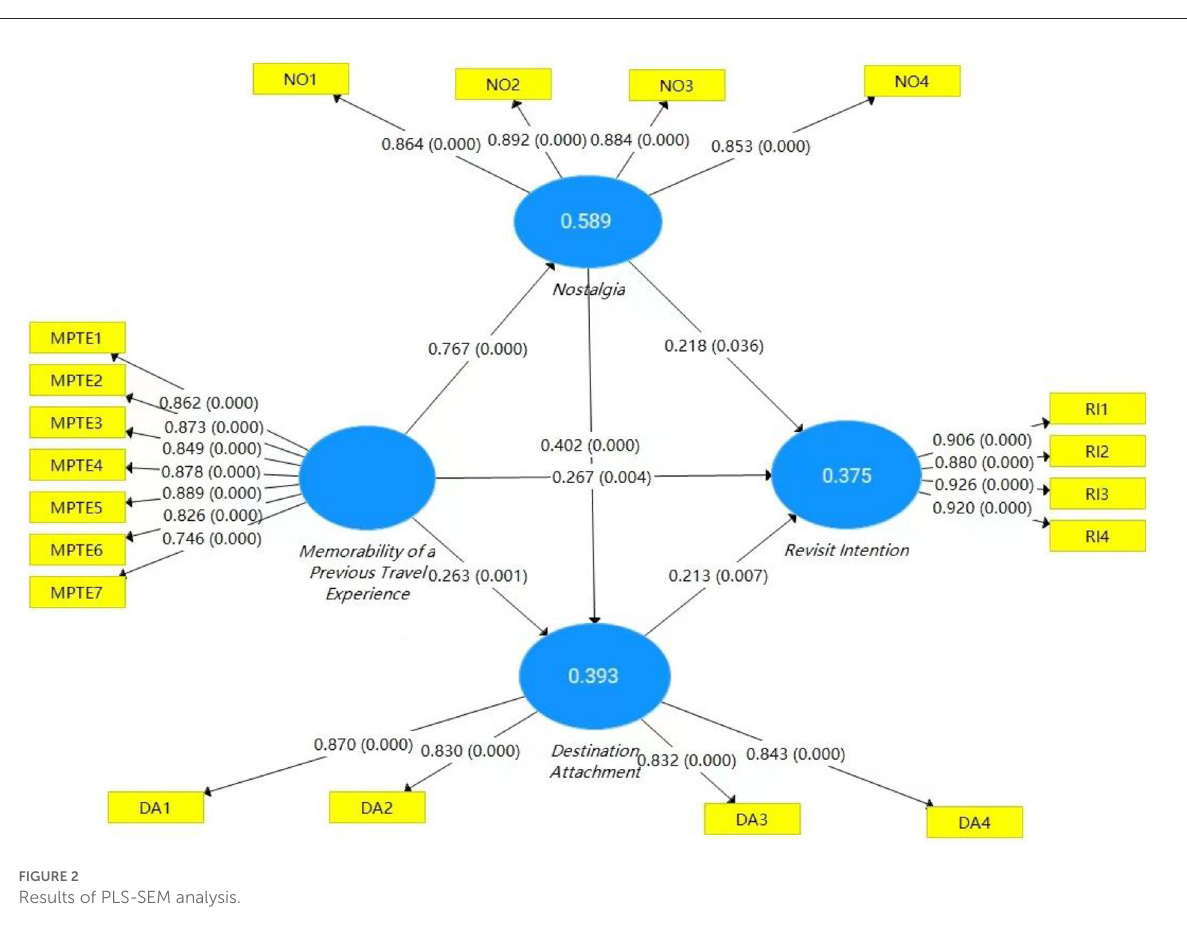
FIGURE2 Results of PLS-SEM analysis.